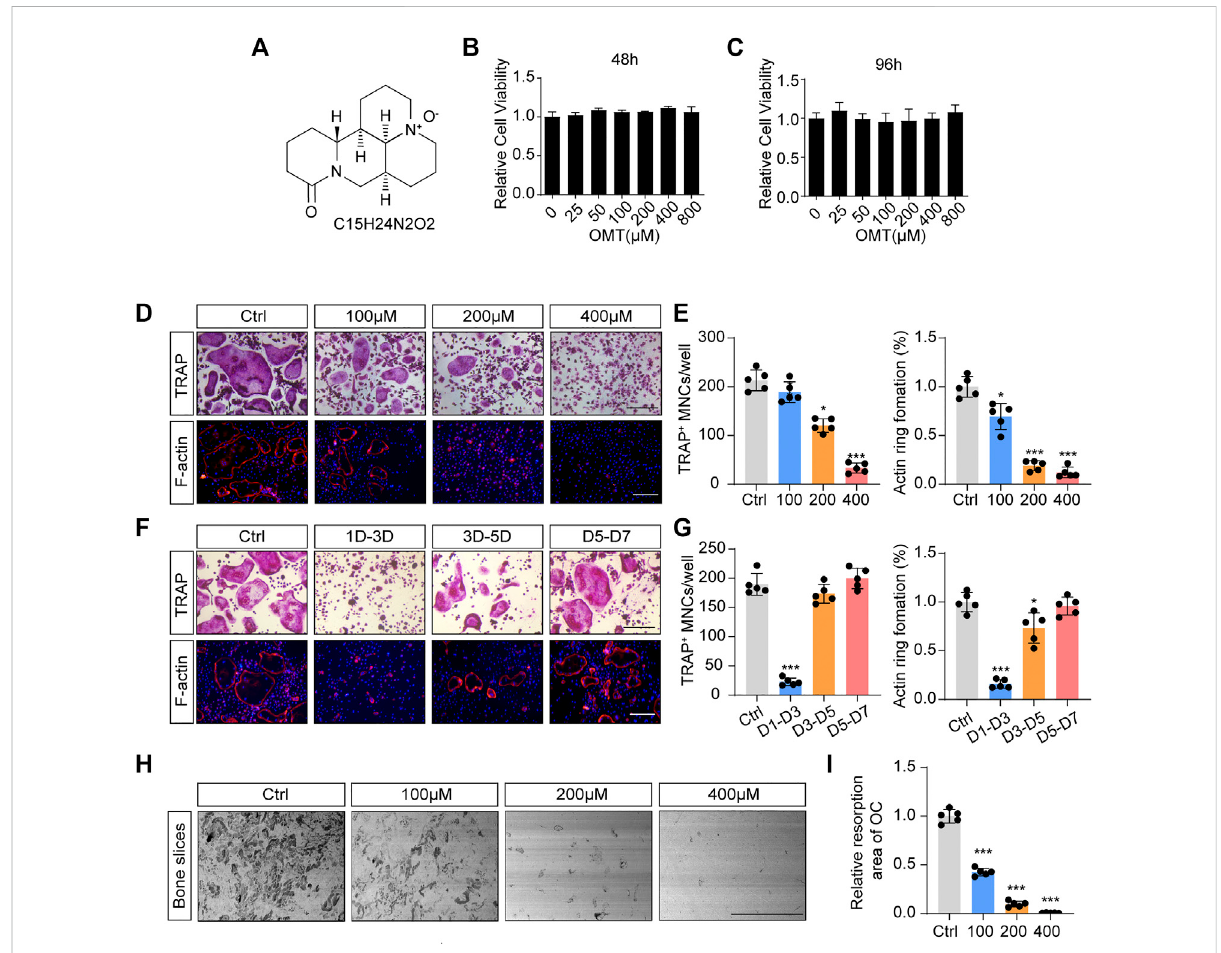
OMT inhibits RANKL-induced osteoclast formation and activity in vitro . (A) The chemical structure and formula of OMT. (B,C) Cell viability of OMT-treated BMMs at 48 and 96 h (D) BMMs were stimulated by 30 ng/mL M-CSF and 50 ng/mL RANKL, and treated with indicatedconcentrationsof OMTfor 5 days. Representativeimagesof TRAPstaining andF-actinstainingwereshown. Scale bar = 200 µm. (E) Quanti fi cation of TRAP-positive multinuclear cells and F-actin ring formation rate. (F) BMMs were stimulated with 30 ng/mL M-CSF and 50 ng/mL RANKL for 7 days, and treated with 200 µM OMT for the indicated days. TRAP staining and F-actin ring staining were performed. Scalebar = 200 µm. (G) Quanti fi cationof TRAP-positivemultinuclear cells and F-actinring formationrate. (H) Representative imagesof